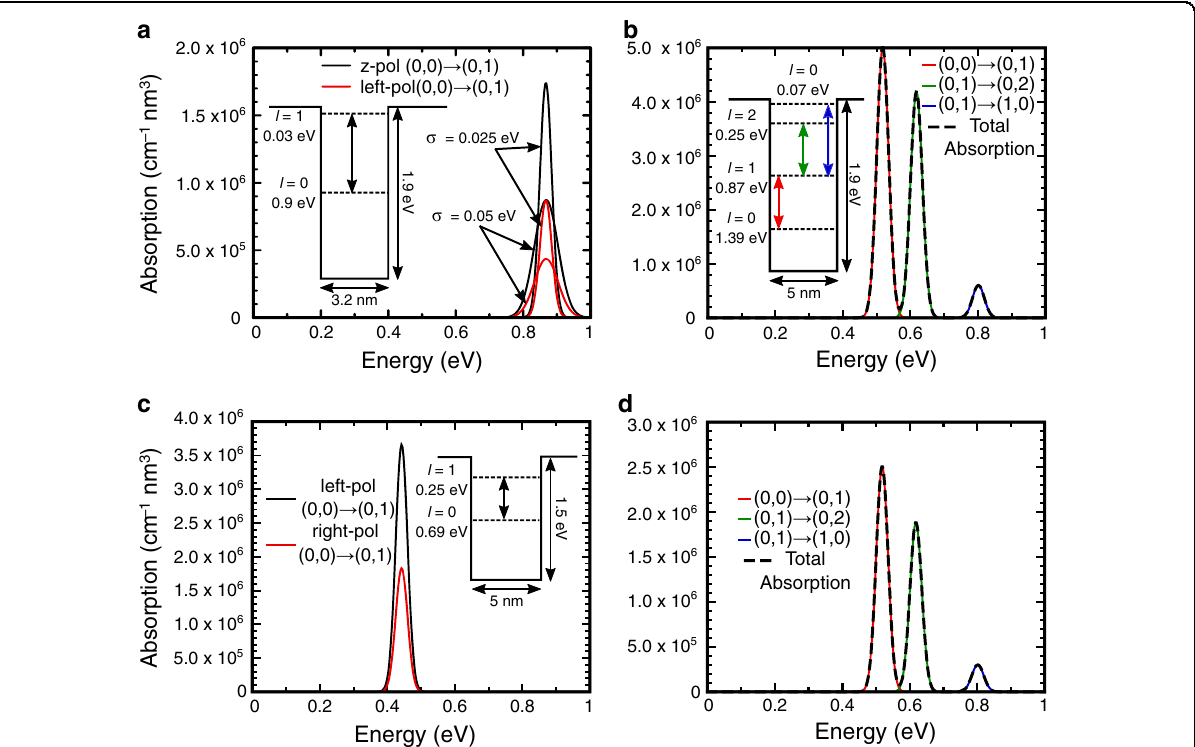
Fig. 4 Absorption coef fi cient per density ( α / ρ qd ) spectra for different QD properties. The inset schematics are the energy band diagrams for each case, showing the allowed transitions. a Spectrum for a 1.6 nm QD with V 0 of 1.90 eV, for z and left polarizations (black and red pro fi le, respectively), and considering two gaussian dispersions, σ , of 0.025 and 0.05 eV (full and dotted lines, respectively). b , d Pro fi les for a 2.5 nm QD with V 0 of 1.90 eV, for z and left polarizations, respectively. The red, green, and blue pro fi les represent each allowed transition. c Pro fi le for a 2.5 nm QD with V 0 of 1.15 eV for z and left polarizations (black and red pro fi le,